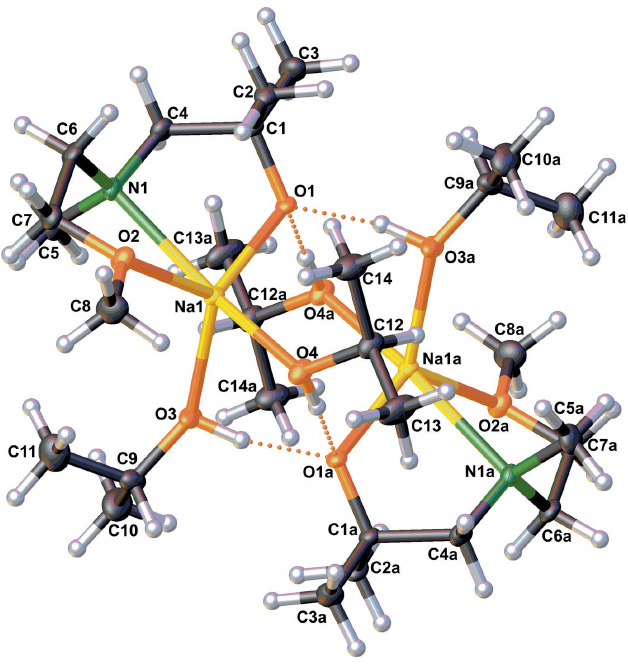
Figure 2 Molecular structure of compound 2 [Na( i -PrOH) 2 (C 8 H 18 NO 2 )] 2 with atom labeling. The asymmetric unit is half of the compound, symmetry operation a = 1 (cid:3) x , 1 (cid:3) y , 1 (cid:3) z